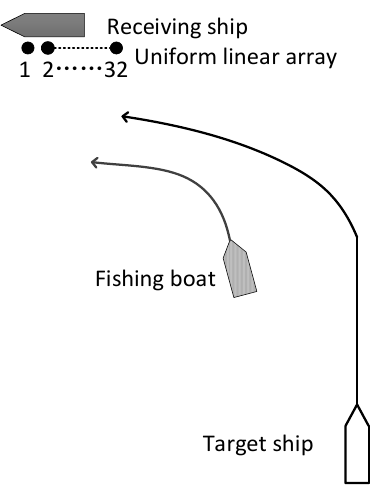
Figure 14. Schematic diagram of the maritime situation during marine trial.